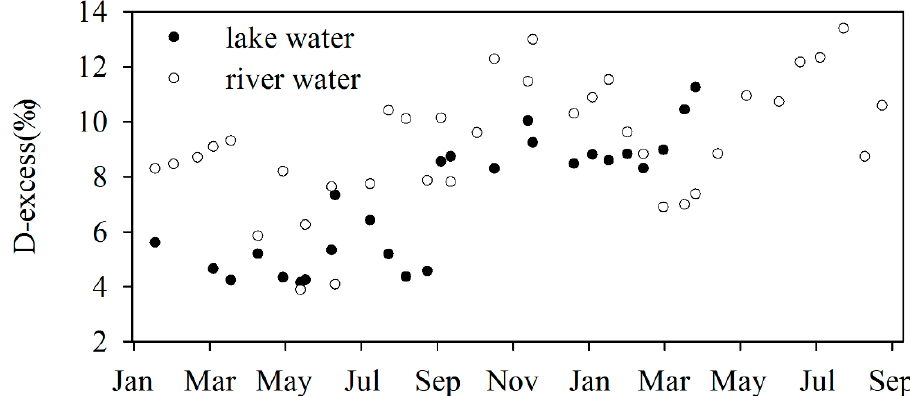
Figure 6. Variation of the D-excess value in ( a ) lake water from January 2016 to March 2017 and ( b ) river water from January 2016 to August 2017.